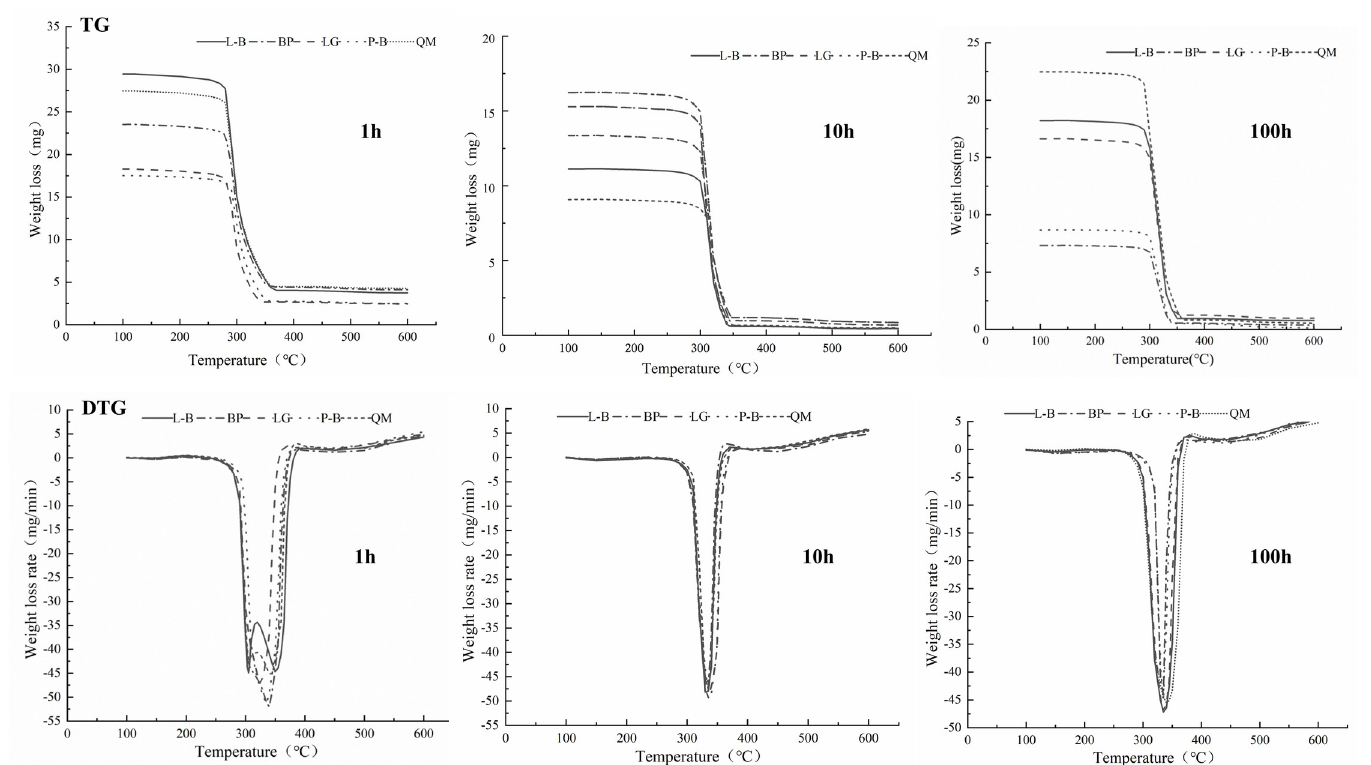
Fig 5. TG and DTG curves of combustibles with 1, 10, 100h time lag in different forest types.